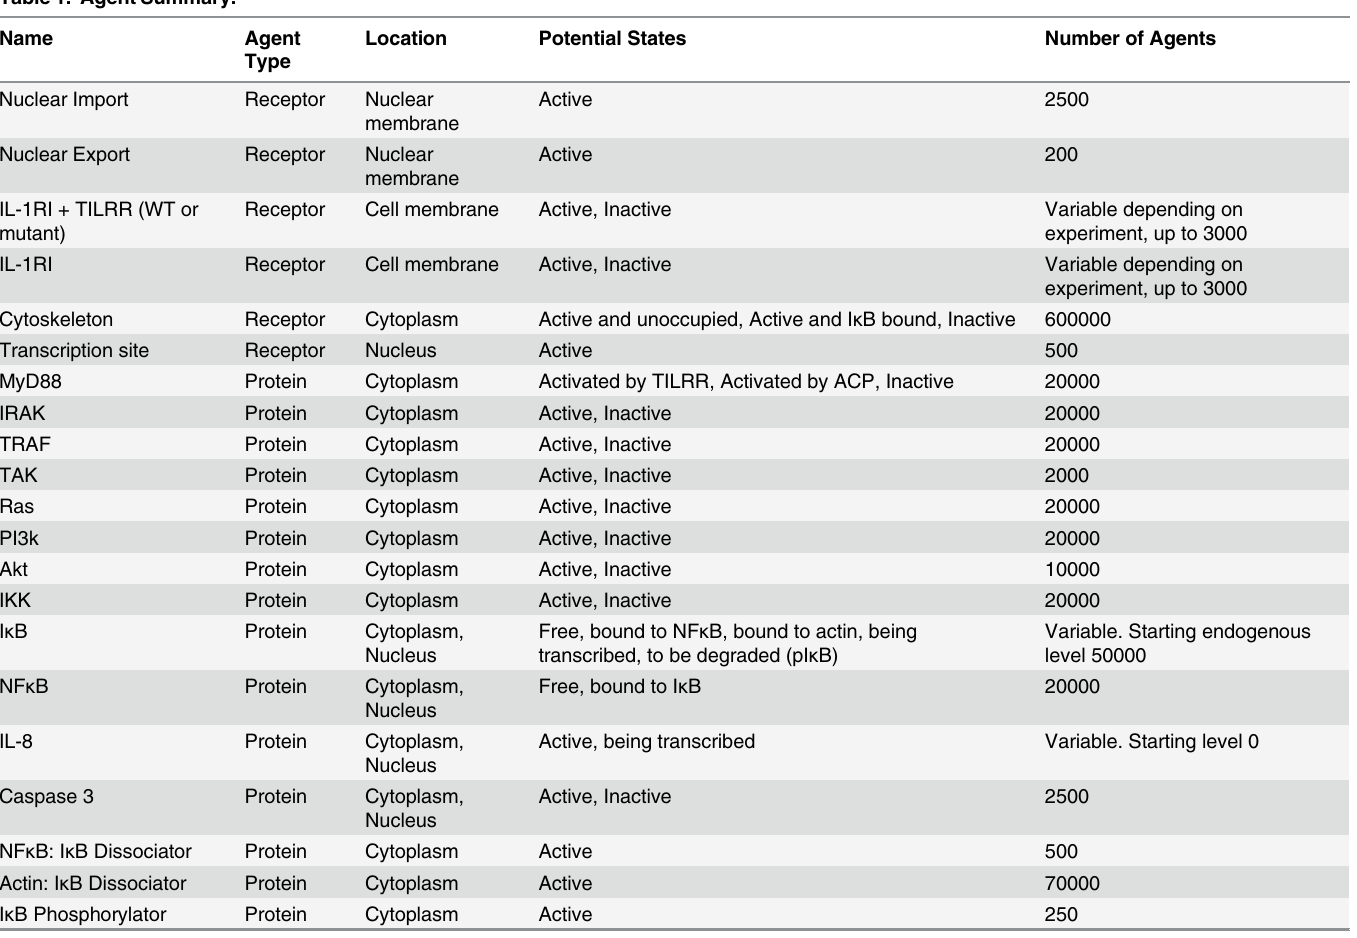
Table 1. Agent Summary.